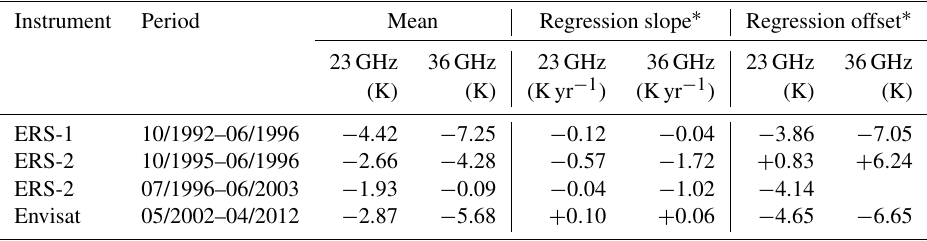
Table 3. Mean optimal bias correction values and regression slopes for the all instruments and time periods. The values given here correspond to the straight lines and dashed lines in Fig. 3. A negative bias correction value means that the observations are warmer than the simulations and thus need to be corrected downwards.